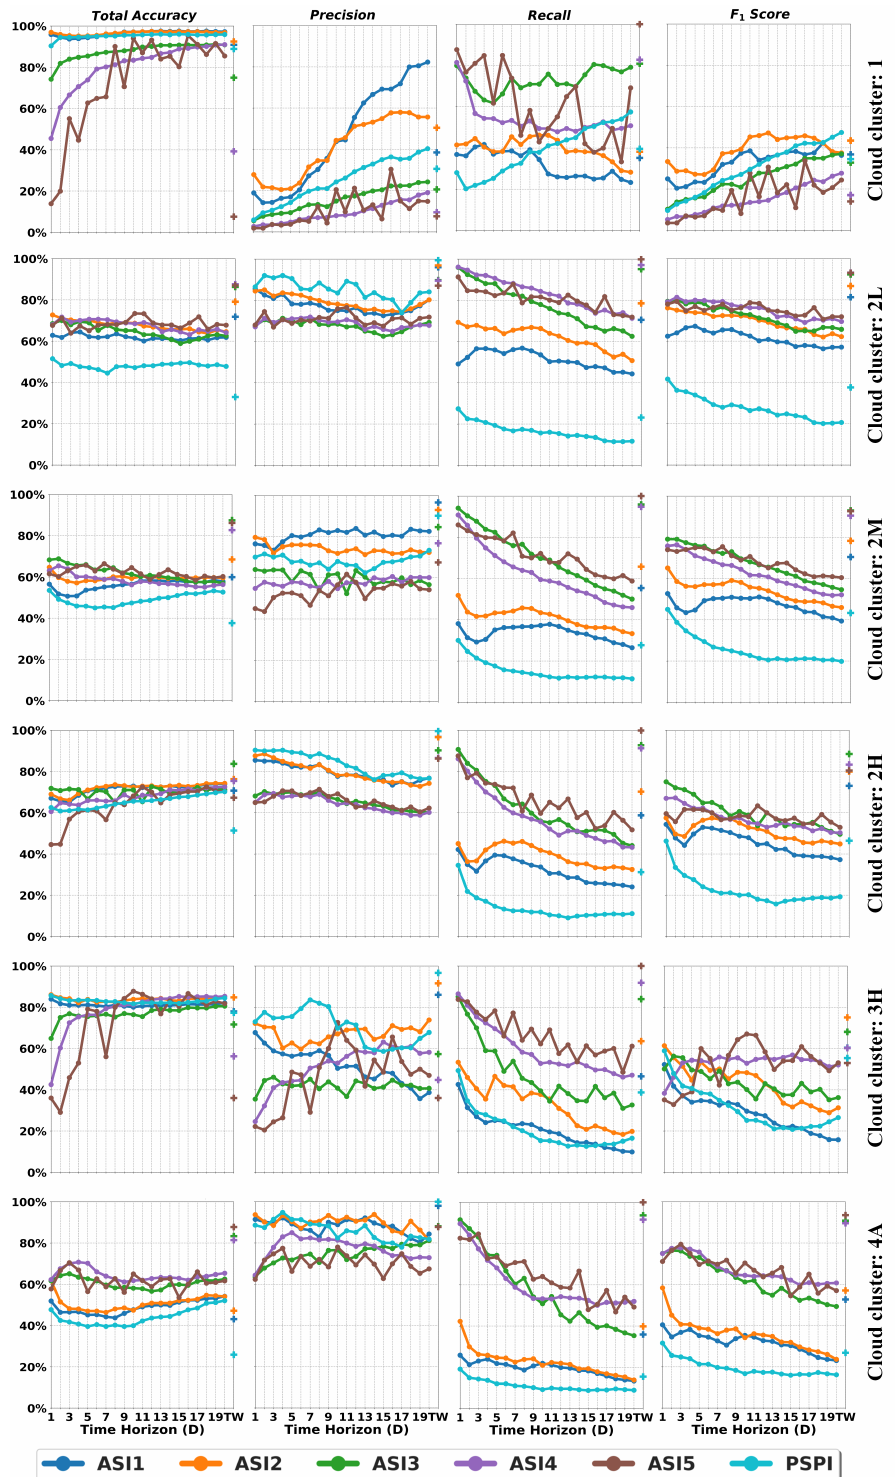
Figure 9. Total Accuracy (1st column), Precision (2nd column), Recall (3rd column) and F1 Score (4th column) for cloud clusters: 1 (1st row), 2L (2nd row), 2M (3rd row), 2H (4th row), 3H (5th row) and 4A (6th row). Each metric is calculated at each time horizon D (up to 20 min, solid lines) and the 20 min time window (TW, star symbol). The definition of each cloud cluster is presented in Section 2. In terms of total accuracy, the revealed values and the best model’s performance differ at different cloud conditions. Under almost clear skies (Figure 9, CC: 1, 1st column 1st